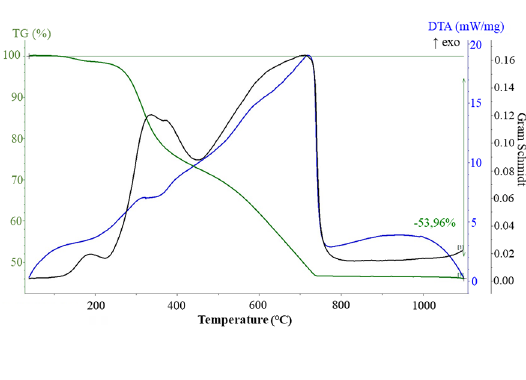
Figure 3. Thermogravimetric and differential thermal analysis of the epoxy resin.